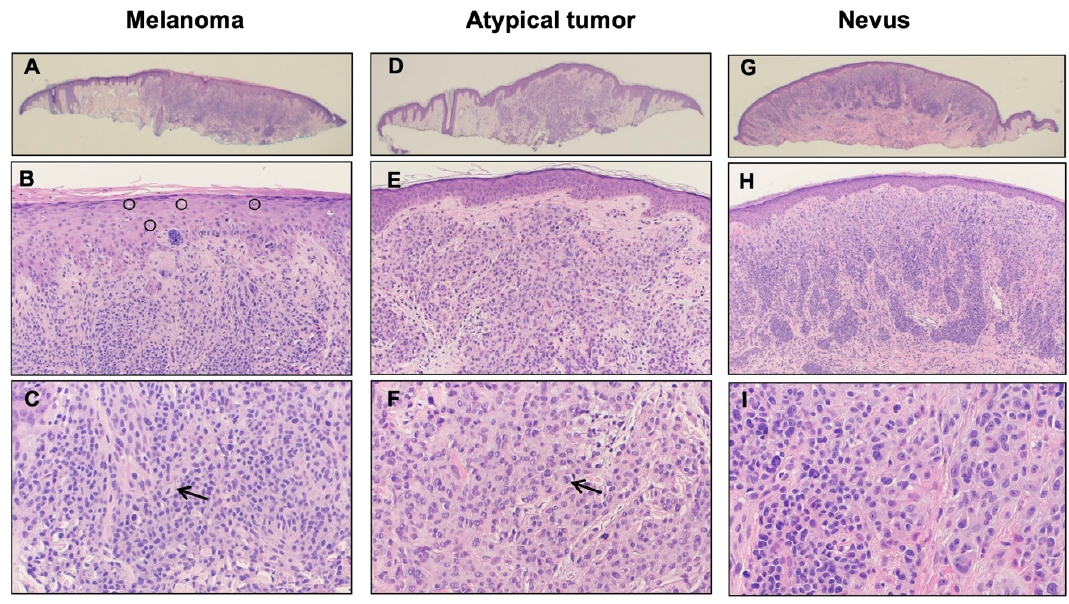
Figure 1. Histopathology of three representative lesions. ( A – C ) Melanoma; an atypical compound melanocytic proliferation with a nevoid appearance at low power ( A ), with abundant pagetoid scatter of single melanocytes within the epidermis (( B ), circles) and multiple dermal mitoses (( C ), arrow); ( D – F ) atypical tumor; a predominantly dermal melanocytic proliferation of atypical yet monomorphous large oval melanocytes with occasional mitoses (( F ), arrow); ( G – I ) nevus; a dermal proliferation of small regular melanocytes in conjunction with large ovoid melanocytes ( I ). Circles ( B ): pagetoid spread of the tumor cells. Arrows ( C , F ):